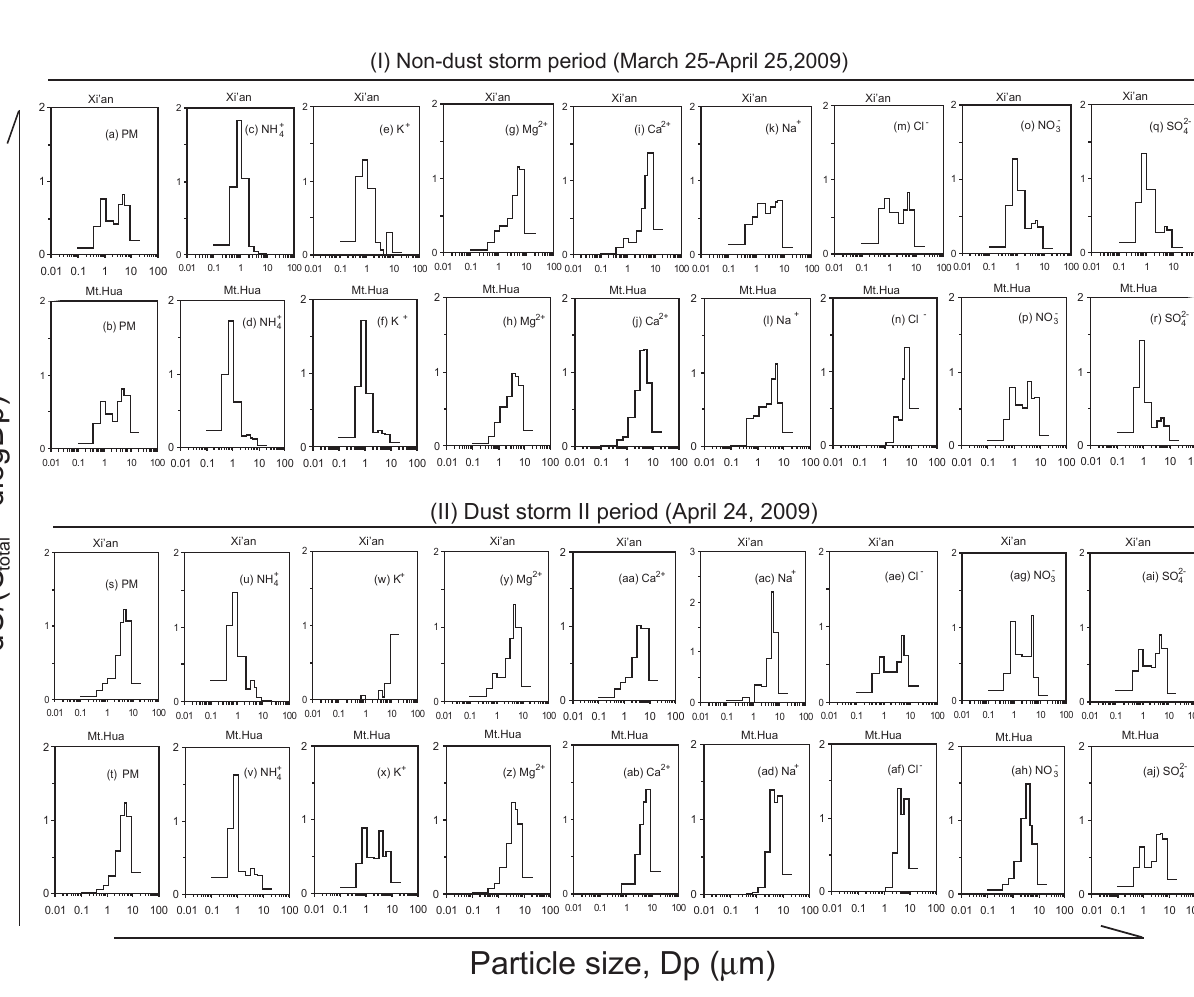
Figure 8. Difference in size distributions of particle mass (PM) and inorganic ions in the atmospheres of Xi’an and Mt. Hua during (I) the non-dust storm and (II) the dust storm periods